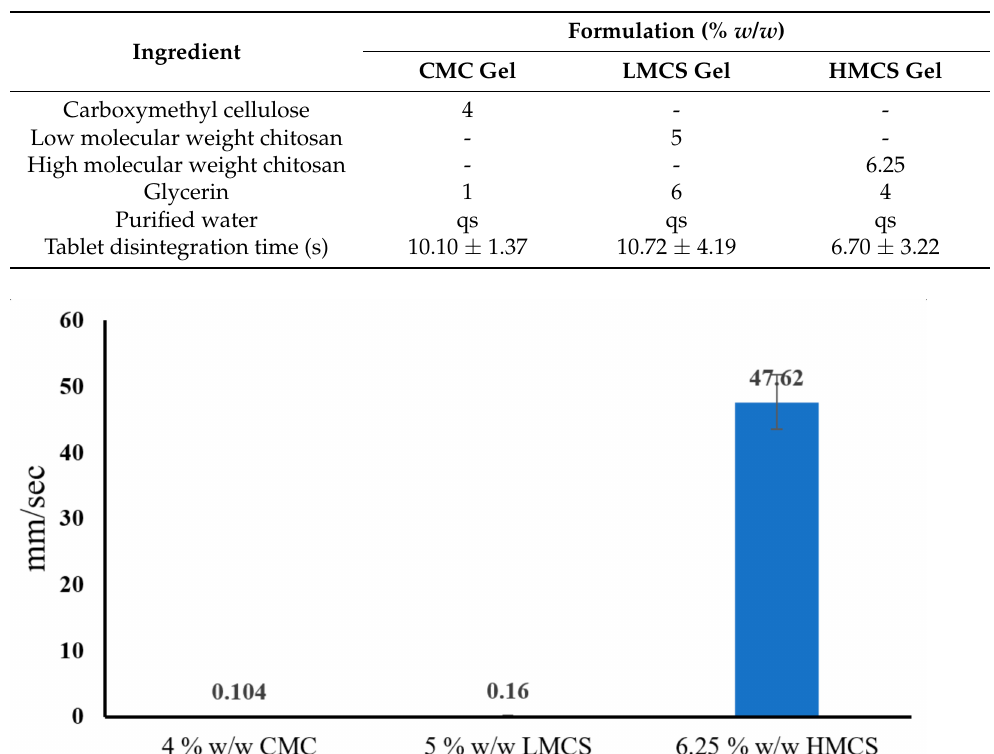
Table 1. Disintegration time of the theophylline tablets covered with the PSG prepared from car- boxymethyl cellulose (CMC), low molecular weight chitosan (LMCS), and high molecular weight chitosan (HMCS), offering proper viscosity and flow ability.